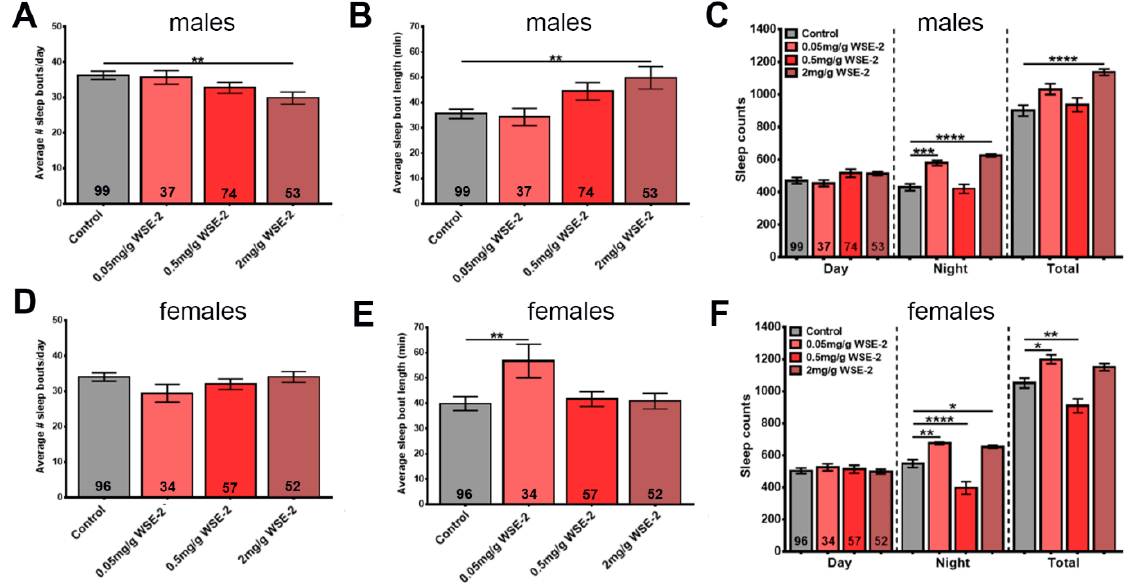
Figure 6. WSE-2 improves sleep in males. Males show a reduction in sleep bout number that reaches significance with 2.0 mg/g WSE-2 ( A ). This is accompanied by an increase in sleep bout length ( B ). WSE-2 treatment increases nighttime sleep and total daily time spent asleep ( C ). Females do not show a change in sleep bout number ( D ), and sleep bout length is only increased with the lowest concentration of 0.05 mg/g ( E ). The 0.05 mg/g and 2.0 mg/g doses increase nighttime sleep, and the lowest dose also increases total time spent asleep, whereas a reduction is seen in both with 0.5 mg/g ( F ). Sleep was analyzed from age 42 d to 50 d. A one-way ANOVA with Dunnett’s multiple comparisons test was used, and the number of analyzed flies is given in the bars. Bars represent means and error bars SEMs. * p < 0.05, ** p < 0.01, *** p < 0.001, **** p < 0.0001 compared to controls on regular food.